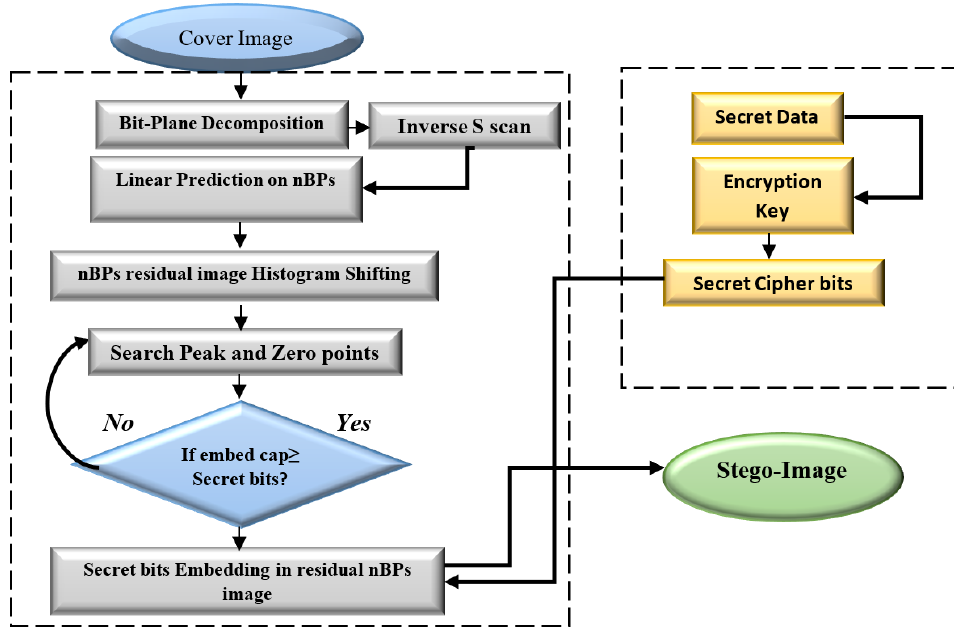
Figure 3. Flowchart of the Embedding Procedure.